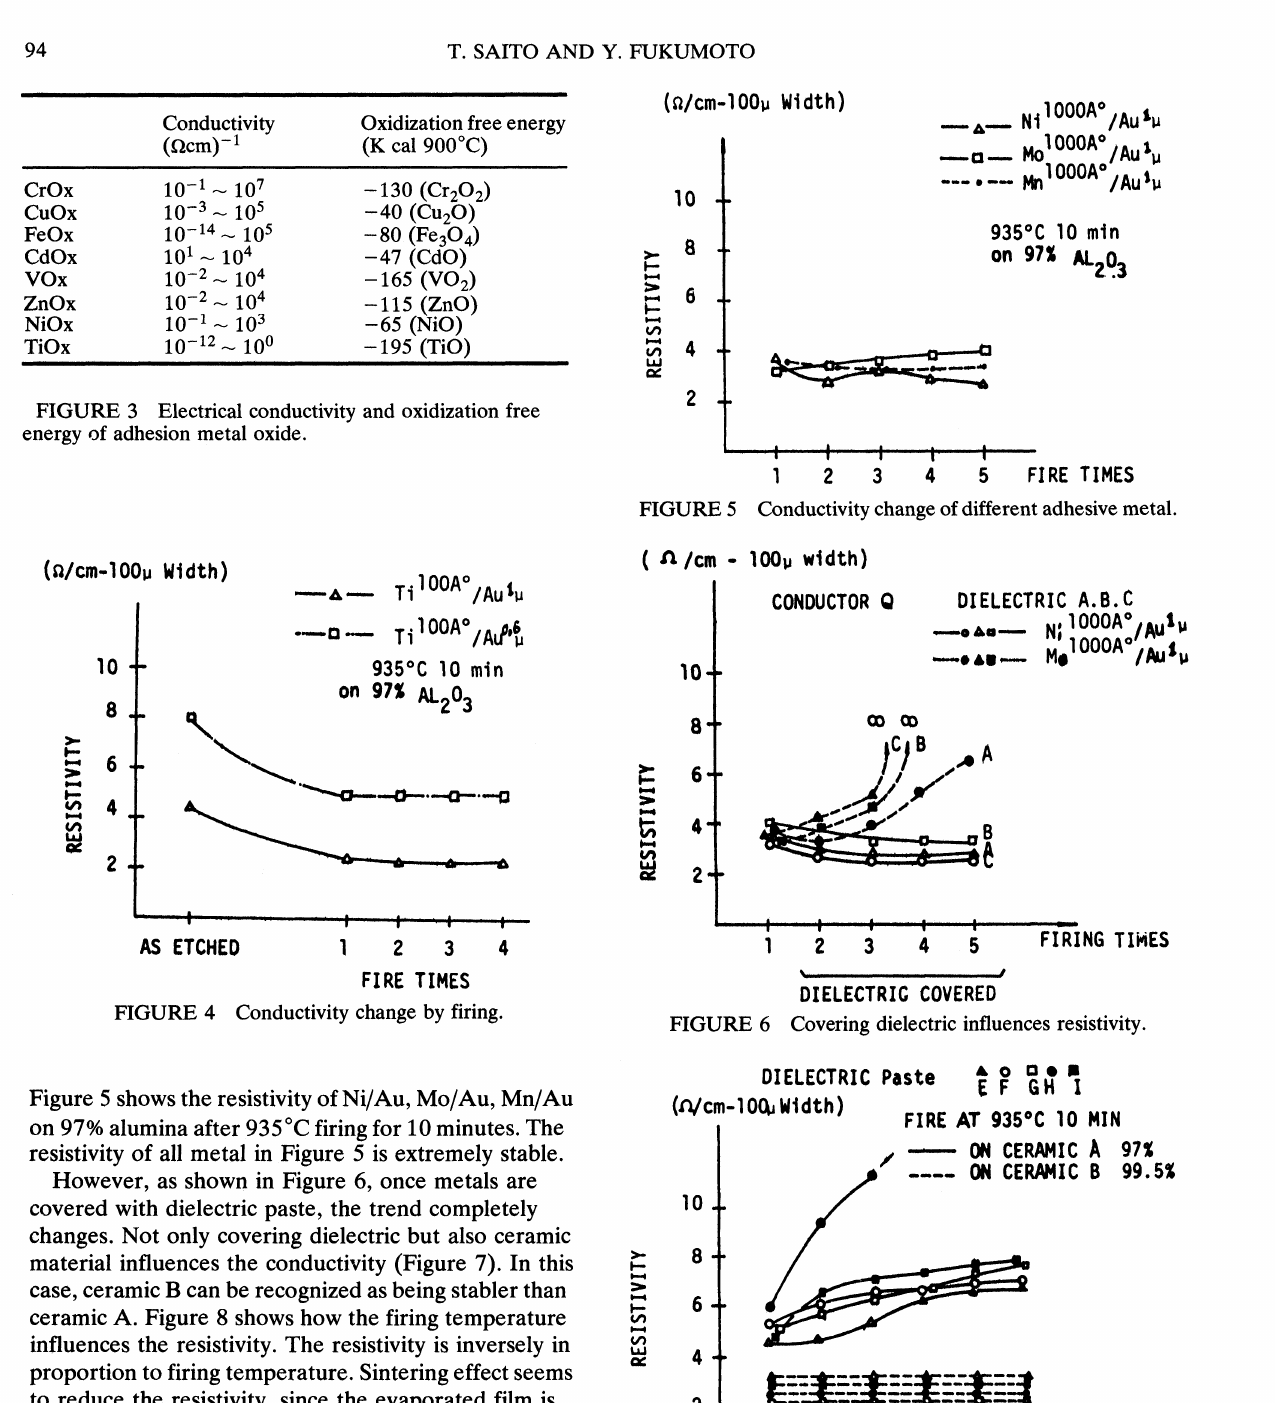
FIGURE 6 Covering dielectric influences resistivity.